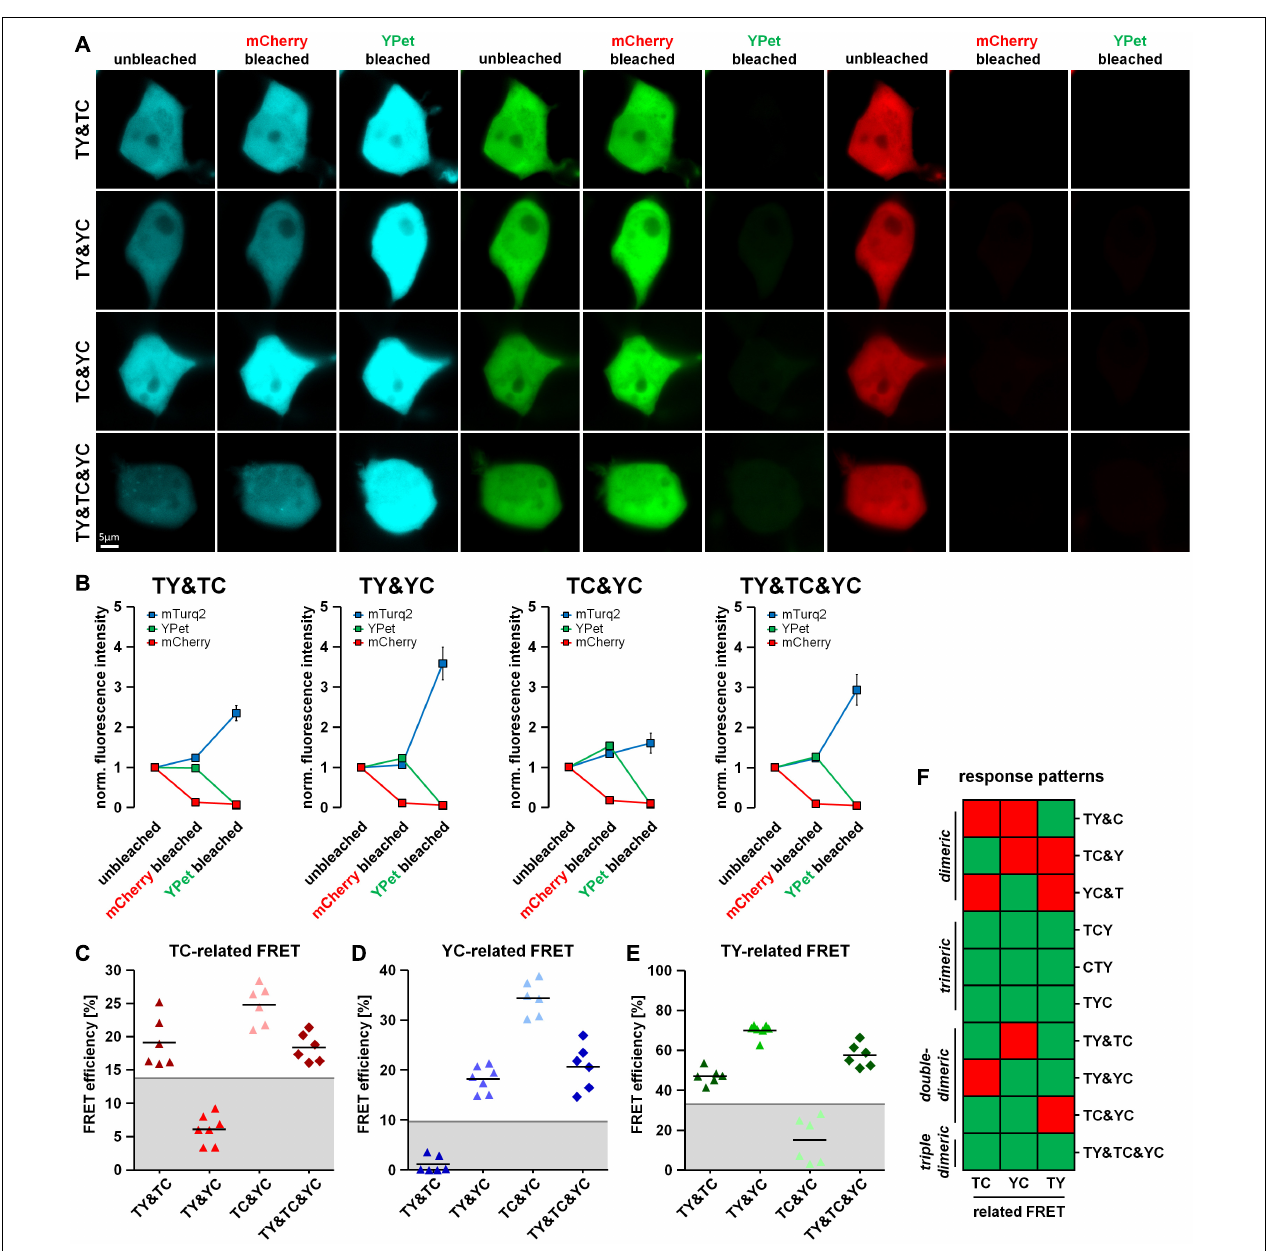
FIGURE 4 | Discrimination of different types of dimeric interactions among three potential interaction partners using fluorescence intensity-based measurements. (A) HEK293T cells were co-transfected with two doublet constructs (TY&TC, TY&YC, TC&YC) or a combination of all three FRET doublets (TY&TC&YC). Representative images showing the fluorescence intensity of mTurquoise2, YPet and mCherry before bleaching (unbleached), after the first bleaching step (mCherry bleached) and after the second bleaching step (YPet bleached). (B) Average fluorescence intensity of mTurquoise2 (blue), YPet (green), and mCherry (red) normalized to the first image acquired ( n = 6). After mCherry bleaching, the YPet fluorescence intensity increased in TY&YC, TC&YC and TY&TC&YC samples, while it slightly decreased in TY&TC. In contrast, the intensity of mTurquoise2 increased in TY&TC, TC&YC and TY&TC&YC but remained rather constant in TY&YC samples. After YPet bleaching, the mTurquoise2 fluorescence intensity drastically increased in TY&TC, TY&YC and TY&TC&YC, only. (C–E) FRET efficiencies calculated from the change in fluorescence intensity of mTurquoise2 (C) and YPet (D) after mCherry bleaching (first bleaching step) and the from the additional relative change of mTurquoise2 fluorescence after YPet bleaching [ (E) , second bleaching step] for double transfections TY&TC, TY&YC and TC&YC as well as the triple transfection TY&TC&YC ( n = 6). Threshold values to discriminate interaction-specific FRET from non-specific FRET are indicated by gray lines. (F) Updated color-coded response patterns and decision matrix of fluorescence intensity-based measurements. For each direction of FRET, a Yes-response (occurrence of specific FRET) is indicated by a green and a No-response (no or non-specific FRET) is indicated by a red square. The patterns can be used to discriminate dimeric from trimeric and double-dimeric interactions. However, the response patterns are not suitable to distinguish between trimeric interactions and triple-dimeric interactions in our experimental approach.